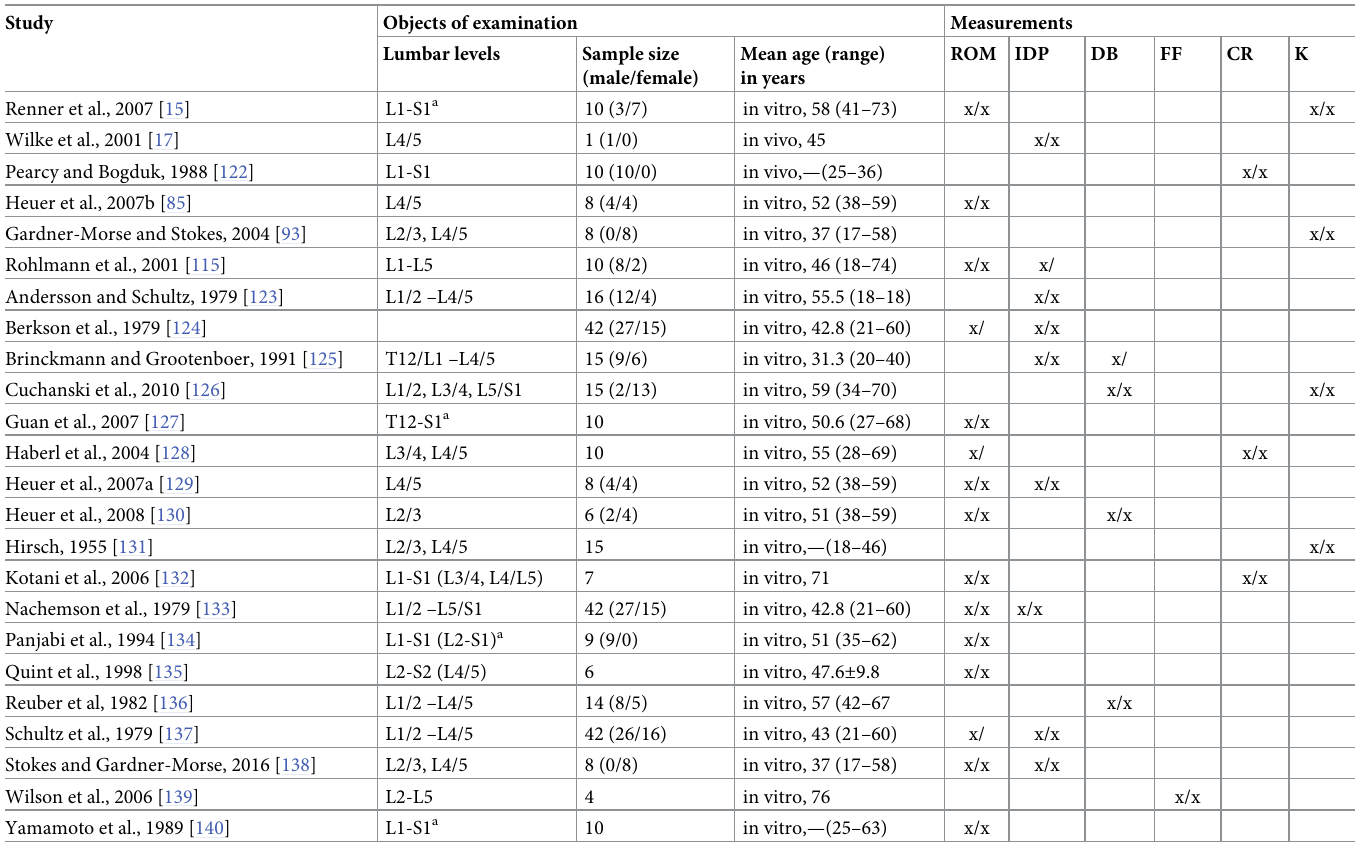
Table 4. Compilation of experimental studies included in calibration and